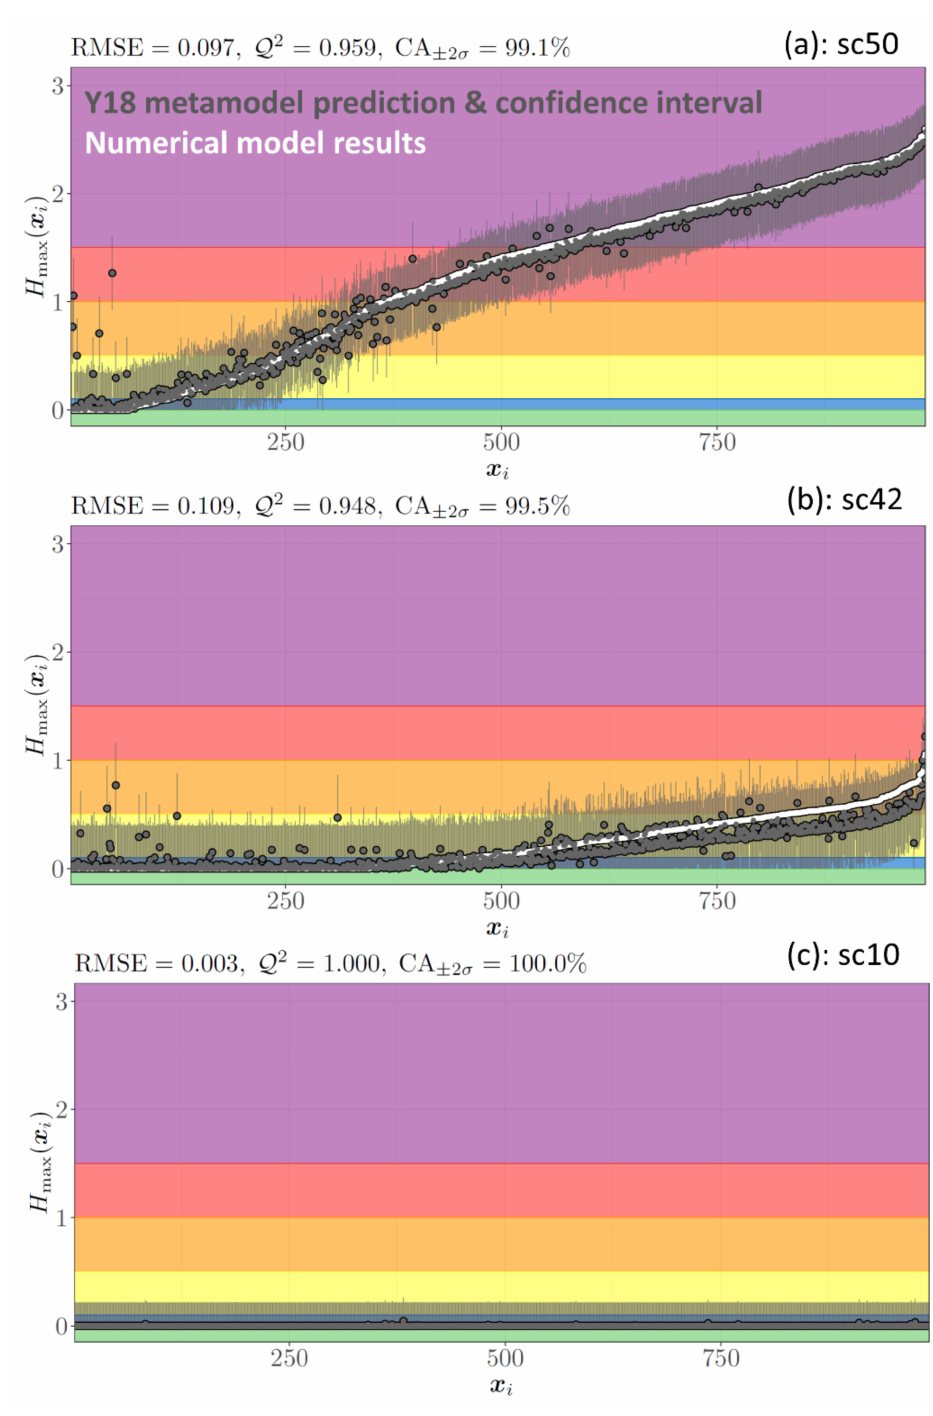
Figure A4. Cross-validation of the maximal water heights predicted by metamodel Y 18 and provided by the numerical model for scenarios 50, 42, and 10 among the 174 learning scenarios. X i is the index of the spatial points (from 1 to 889, sorted in increasing order using the numerical results for each scenario). The panels show the RMSE, Q 2 , and CA (coverage accuracy) indicators. The CA indicator quantifies how many test points are contained in the two standard-deviation (denoted σ ) confidence